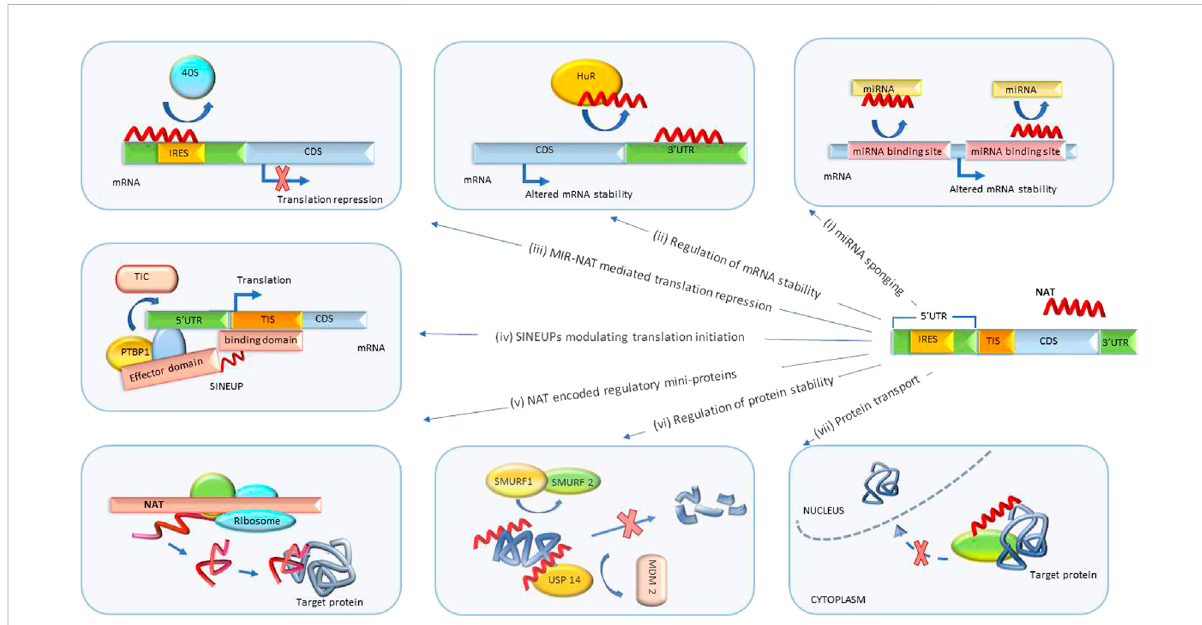
FIGURE 3 Post-transcriptional biological processes regulated by NATs. (i) miRNA sponging. NATs regulate mRNA degradation by sponging miRNA or blocking miRNA binding sites. (ii) Regulation of mRNA stability. NATs sponge proteins regulating mRNA degradation and stability. (iii) MIR-NAT- mediated translation repression. MIR-NATs overlapping 5 ′ UTRs head-to-head compete with IRES for 40S ribosome subunit and repress translation. (iv) SINEUPs modulating translation initiation. The binding domain of SINEUP overlaps the translation initiation site and the effector domain recruits proteins (such as PTBP1) mediating assembly of translation initiation complex (TIC), resulting in translation upregulation. (v) Regulation by NAT-encoded mini-proteins. NATs can encode short peptides with downstream regulatory functions. (vi) Regulation of protein stability. NATs protect target proteins from degradation by sponging/inhibiting activity of proteins involved in ubiquitin-proteosome degradation pathway (such as SMURF1/2, MDM2). (vii) Protein translocation. NATs modulate subcellular distribution of proteins. UTR, untranslated region; CDS, coding sequence; MIR-NAT, mammalian-wide interspersed repeat natural antisense transcript; IRES, internal ribosome entry site; HuR, Hu-antigen R/ELAV-like RNA- binding protein 1; SINEUP, inverted SINEB2 sequence-mediated upregulating molecules; TIC, translation initiation complex; PTBP1, polypyrimidine tract binding protein-1; TIS, translation initiation site; USP14, ubiquitin-speci fi c protease 14; SMURF1/2, SMAD-speci fi c E3 ubiquitin protein ligase 1; MDM2, MDM2